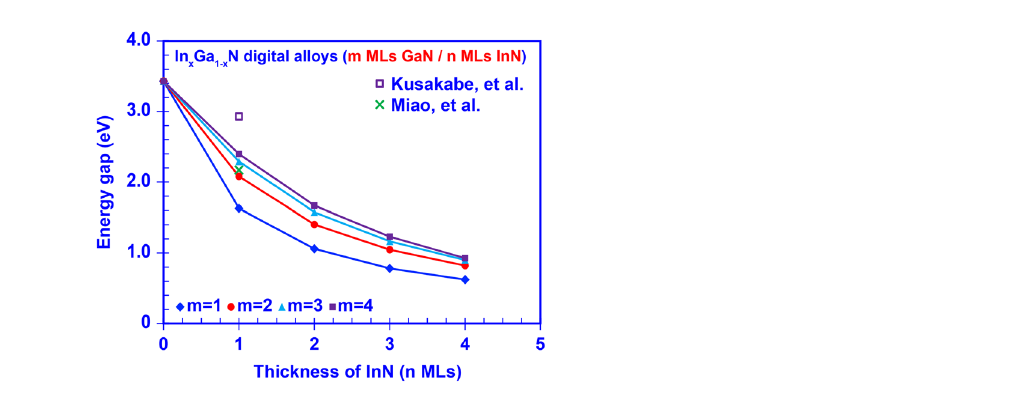
Figure 4. Effective energy gap of the 50-periods InGaN digital alloys formed by m MLs GaN and n MLs InN binary